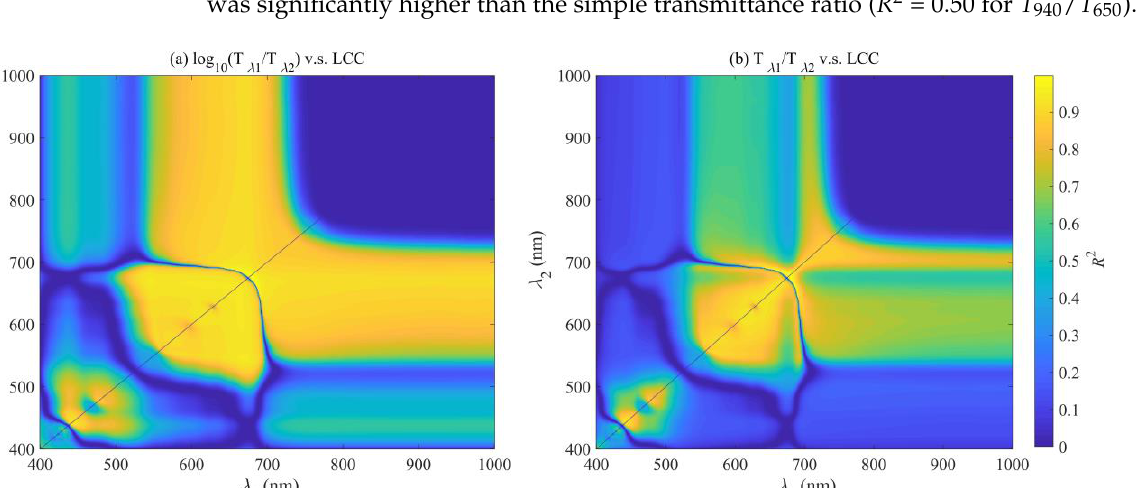
) ( a ), and T ( T λ 1 / T λ 2 ( b λ 1 / T λ 2 10